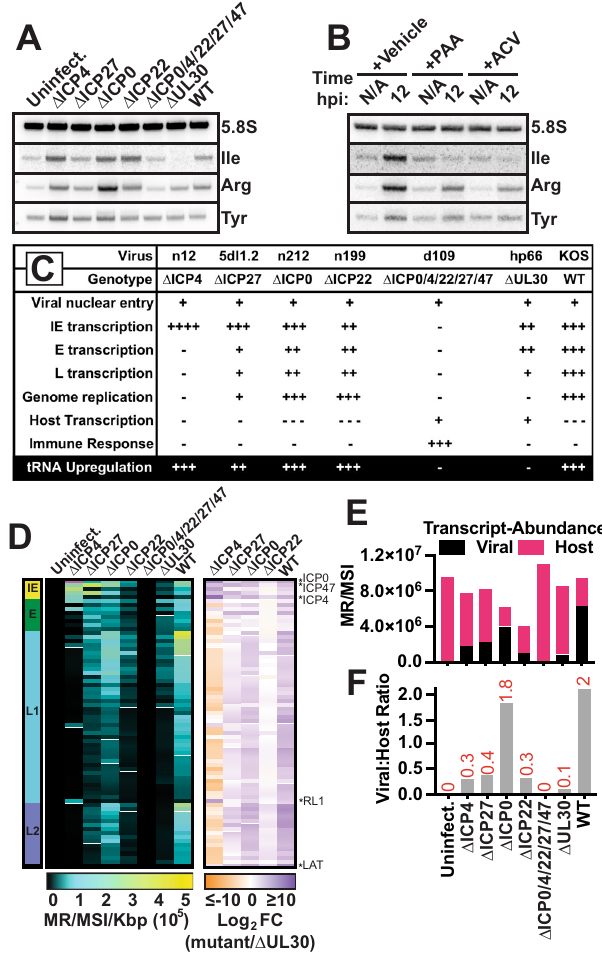
Fig. 3 De fi ning HSV-1 processes required for tRNA upregulation. Human fi broblast cells were mock-infected or infected with Δ ICP4 (n12), Δ ICP27 (5dl1.2), Δ ICP0 (n212), Δ ICP22 (n199), Δ ICP0/4/22/27/47 (d109), Δ UL30 (hp66), or wild-type HSV-1. RNA was isolated at 12 hpi, and A , B Northern blots, or D – F Ribo-depleted Total RNA-Seq was used to assess transcript abundance. A , B Representative Northern blot images. Northern blots were performed for a minimum of two biological replicates, and quanti fi cation is in Supplementary Fig. 5. C Summary of phenotypic differences between HSV-1 mutants used. D Heatmaps for viral transcripts clustered by kinetic class with yellow as immediate early, green as early, blue as leaky late (L1), purple as true late (L2), and black as latency (LAT). Transcripts highlighted with asterisks are upregulated (log 2 fold change> 0) in all mutants relative to Δ UL30 infection. E , F All RNA-Seq reads mapping to the host or viral genome assembly plotted as abundance (mapped reads per million ERCC spike-in reads, MR/MSI) or as the ratio of normalized viral transcripts: normalized host transcripts (Viral:Host